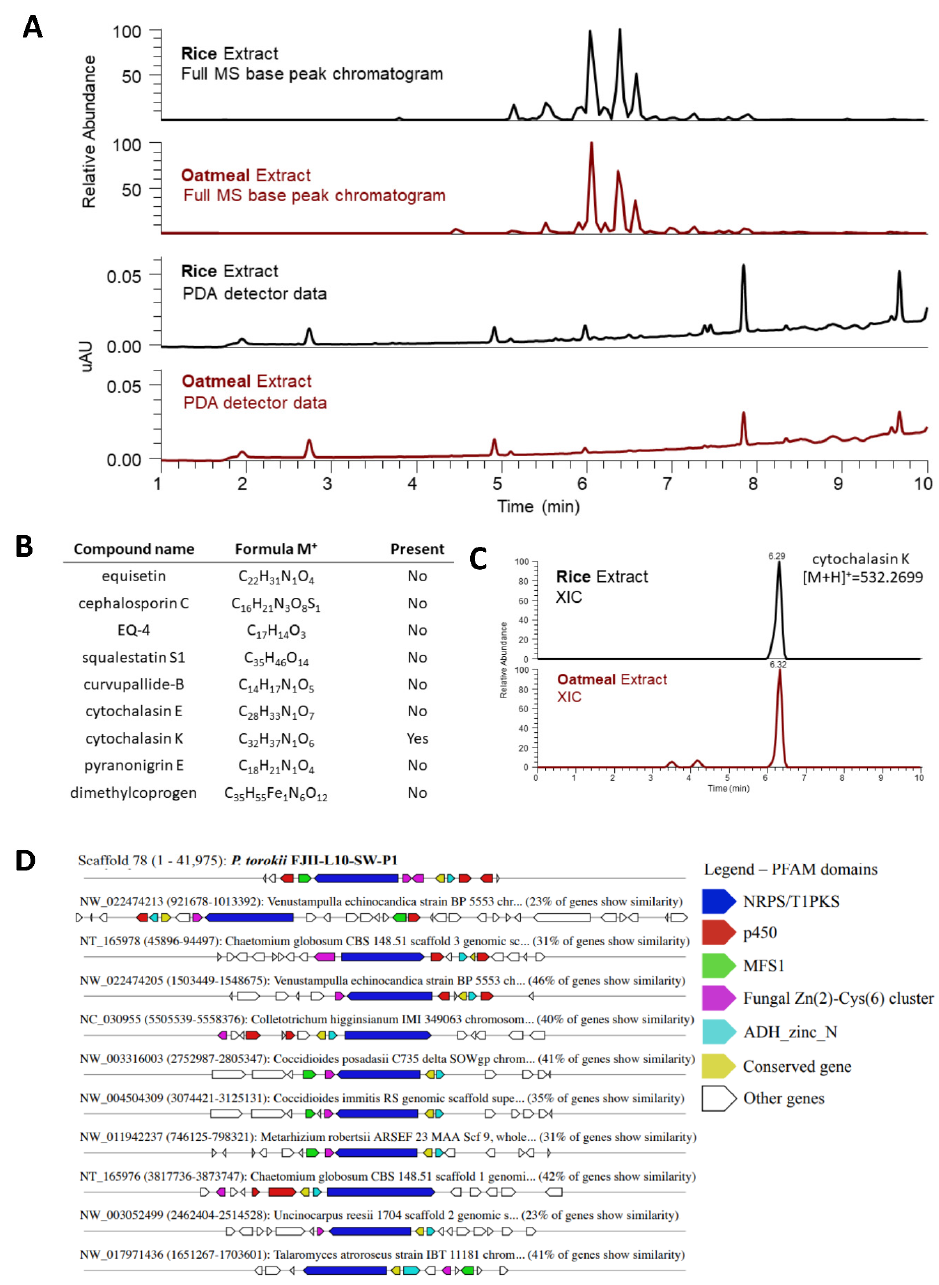
Figure 8. LC-MS comparison of FJ11-L10-SW-P1 grown on oatmeal and rice media. ( A ) The fungus was grown on two different media to examine its secondary metabolite production. Extracts of the fungus were examined through high-resolution mass spectrometry (HRMS). The base peak chromatogram along with light absorbance data collected through Photodiode-Array Detection (PDA) was compared. The extracts showed high similarities in their metabolomic profiling. ( B ) The fungal extracts were screened for natural compounds that are known to be expressed by the identified biosynthetic gene clusters. ( C ) The accurate mass of cytochalasins K was identified through extracted- ion chromatogram (XIC) within 5 ppm of the compound’s accurate mass value. Thus, cytochalasin K was putatively biosynthesized by this fungus under the used growth conditions. ( D ) Predicted cluster of cytochalasin K identified in the P. torokii FJ11-L10-SW-P1 genome. The scaffold and positions spanning the biosynthetic cluster as well the genes are displayed along the schematic representation. The same cluster was identified for a series of other filamentous fungi, which are also